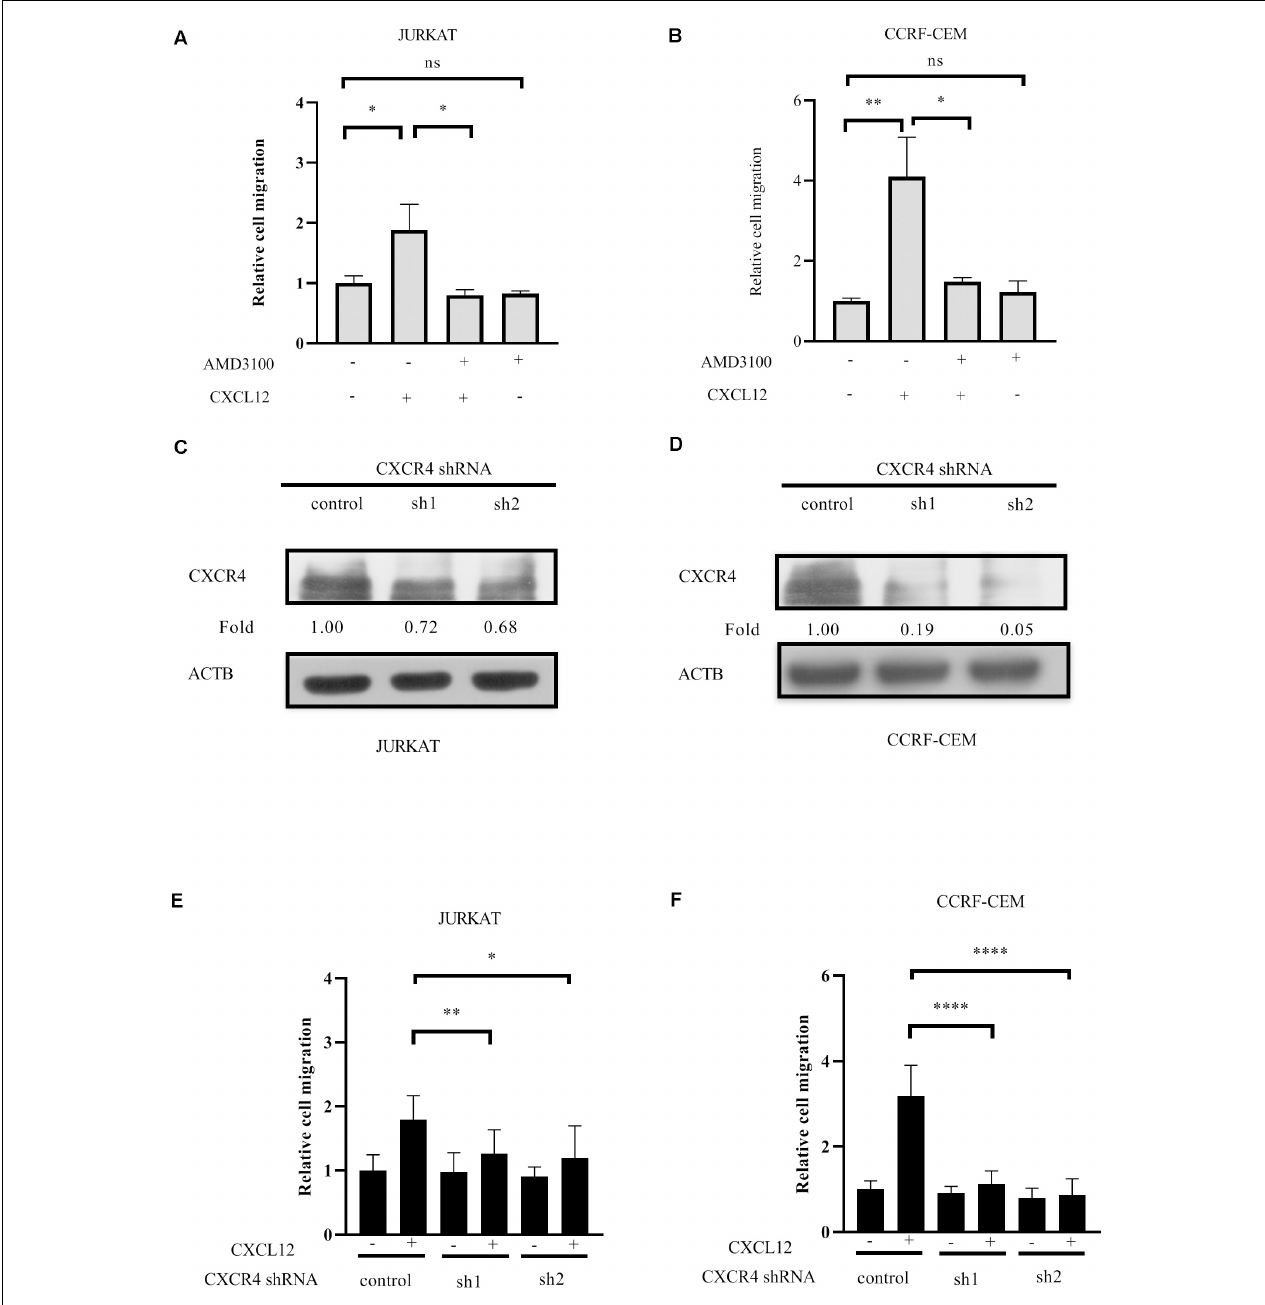
FIGURE 1 | CXCR4 mediates T-ALL cell migration toward CXCL12. (A,B) Starved cells were pretreated with 500 ng/ml AMD3100 or equal concentration of solvent on ice for 30 min, washed with medium, and 3 × 10 5 cells in 100 µ l were used in the following transwell assay. The relative migration rate is shown. (C–F) Cells were infected with lentivirus containing CXCR4 shRNAs and control shRNA. Then, 72 h after infection, the interference efficiency of shRNAs to CXCR4 was detected by Western blot using CXCR4 antibody (C,D) , and transwell assays were conducted (E,F) . Each experiment was repeated at least three times. Western blot bands were analyzed using Image Pro Plus 6.0, and fold changes of CXCR4 were normalized according to ACTB. ACTB was used as the loading controls. * p < 0.05, ** p < 0.01, **** p < 0.0001.